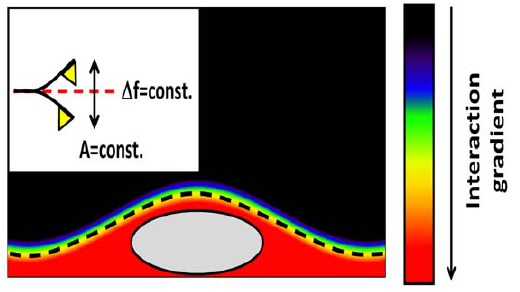
Figure 1. Inliquid FM-AFM basis. Artistic draw of a virus particle immersed in a buffer solution and adsorbed on a surface. The colored environment represents the total gradient of short and long-range interactions between the cantilever tip and the sample. FM-AFM follows the constant gradient lines to get the sample topography.